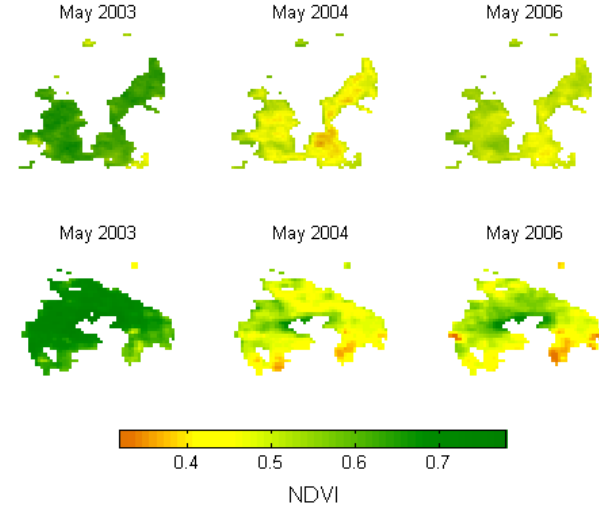
Fig. 7. Fields of NDVI in May 2003–2006 over the two selected large fire scars located in Region I (upper panels) and in Region II (lower